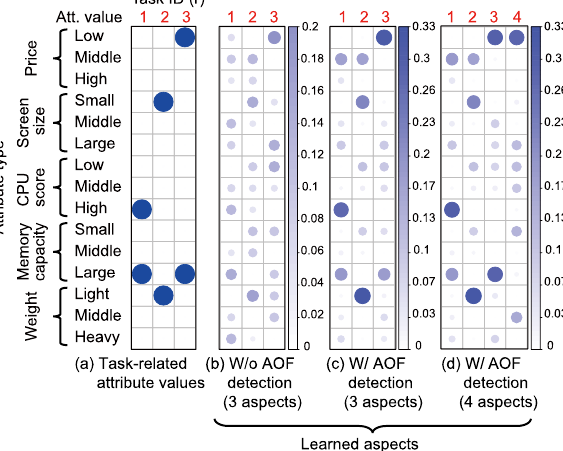
without and with AOF detection step using eye gaze data. In (b) and (c), the number of aspects was set to three (the same as that of the tasks) while it was set to four in (d). The size and color of each dot both depict the value of the multinomial parameter 𝒑 𝒓,𝒌 , which represents the degree that aspect 𝑪 𝒓 is associated with attribute value 𝑽 𝒌 .